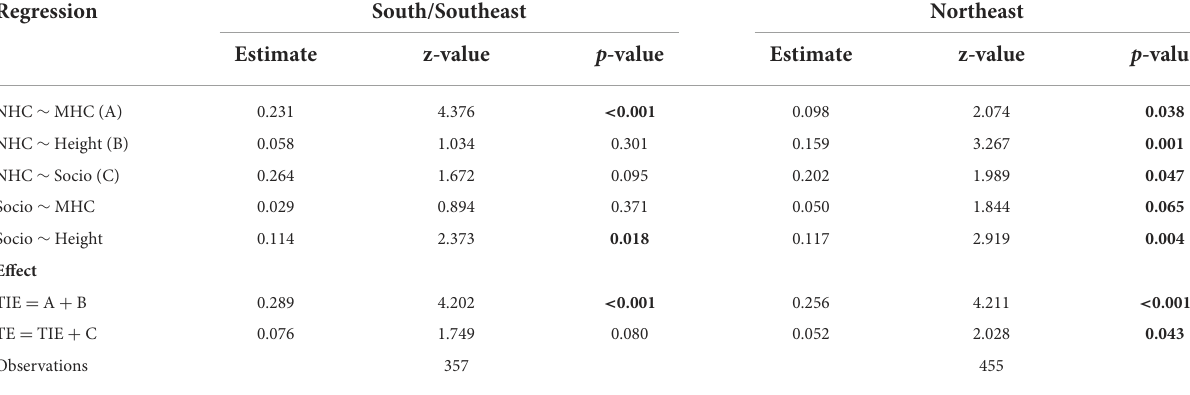
TABLE 4 Regression parameters from “Path Analysis” using latent variables and defined parameters according to regions. Regression